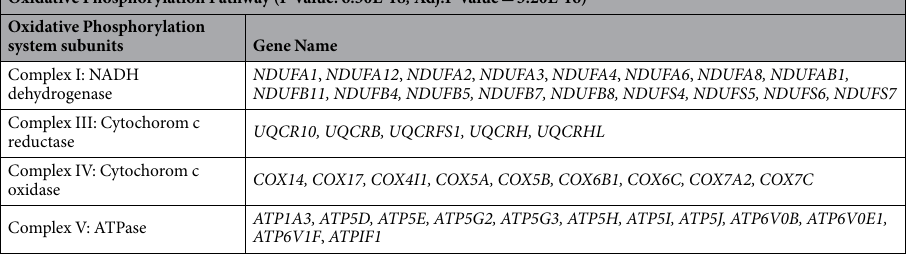
Oxidative Phosphorylation Pathway (P-value: 6.50E-18 ; Adj.P-value = 5.20E-16)